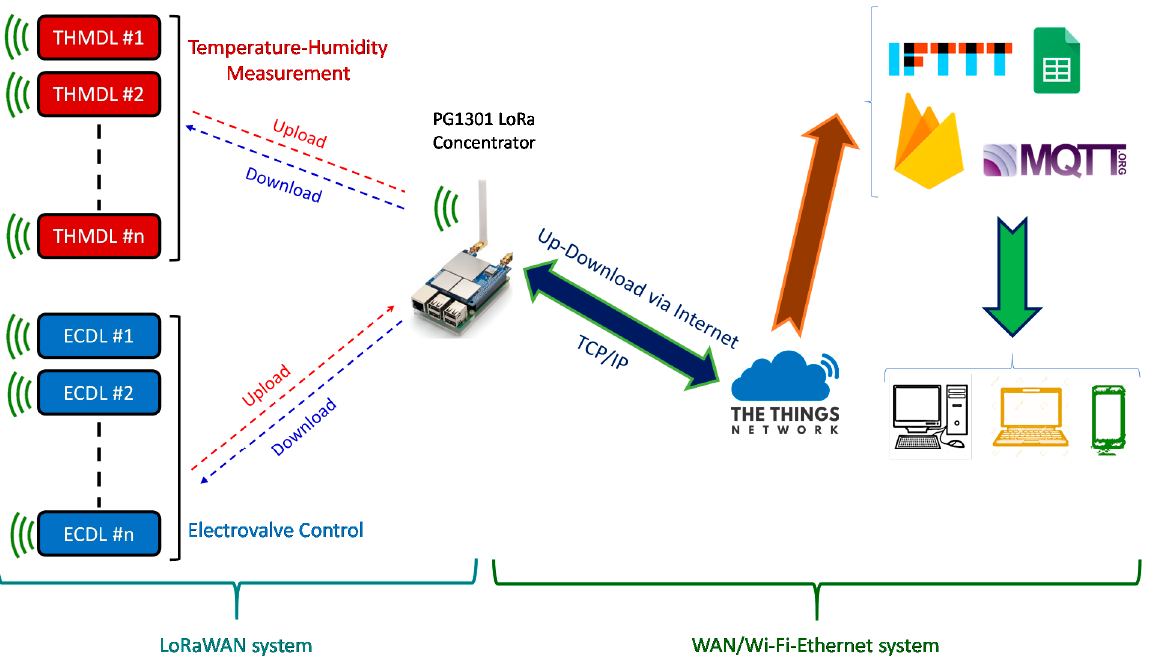
Figure 1. Proposed network scheme.